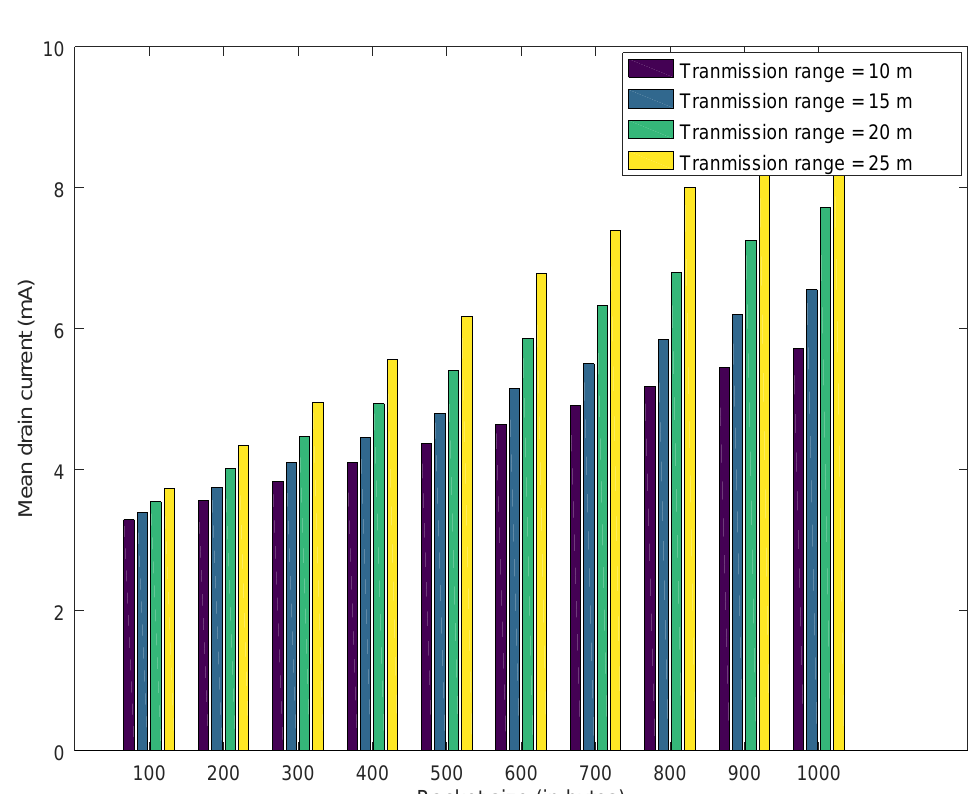
Figure 18. Required Current for the device - Average